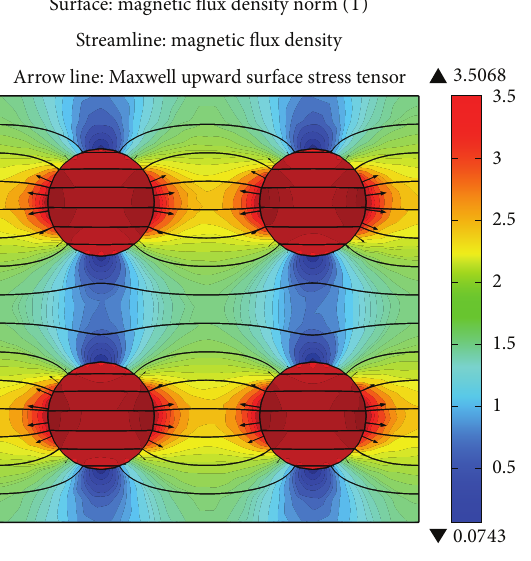
Figure 7: Magnet flux density in MRE.